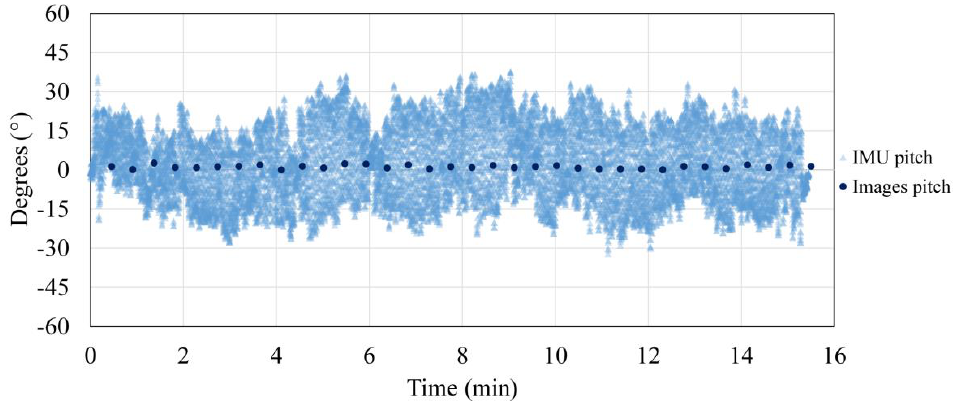
Figure 7. Exterior orientation parameters acquired photogrammetrically and by the Inertial Measurement Unit (IMU) for pitch parameter.